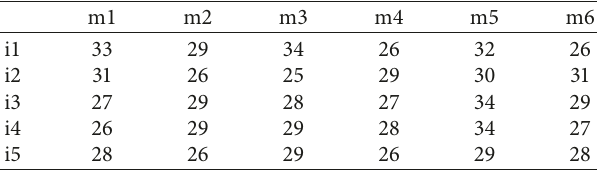
Table 8: Cost of transferring relief goods from supplier to central distributor.